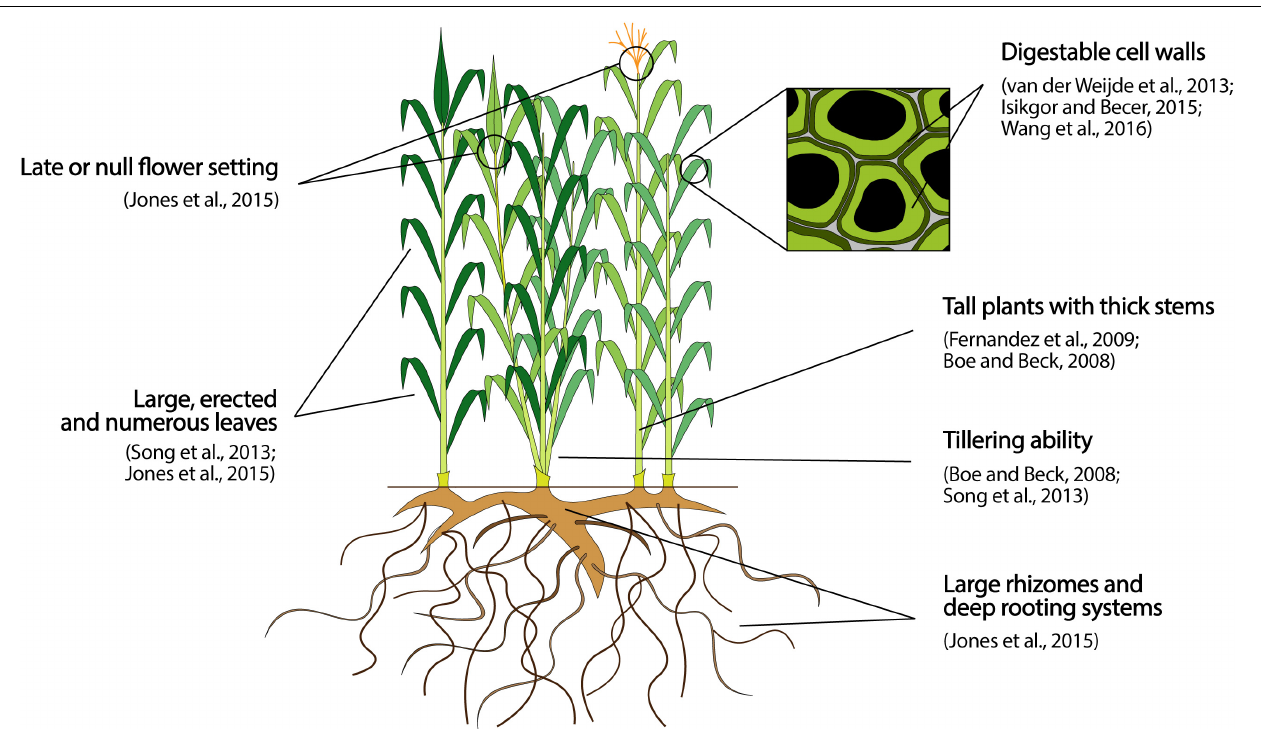
FIGURE 1 | Preeminent architectural, phenological, and quality target traits to breed perennial lignocellulosic biomass crops for biomass production on MALs. The traits reported represent an ideotype to guide breeding activities, and the effective magnitudes of improvement attainable with respect to each trait can vary extensively depending on the species object of a breeding